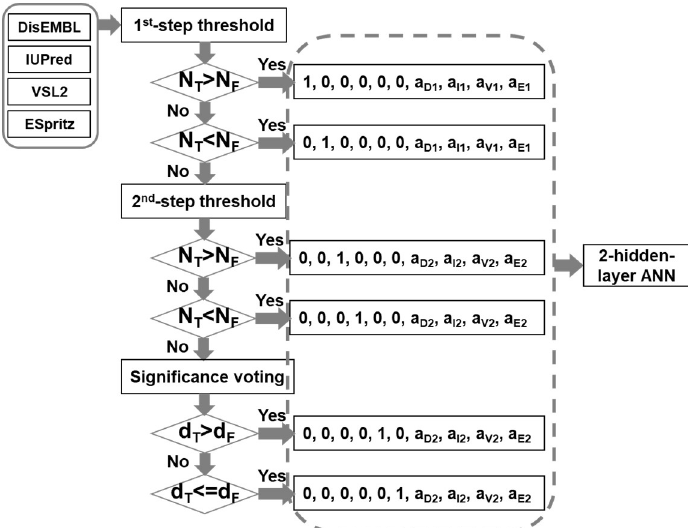
Figure 6. Infrastructure of the new meta-strategy. N T and N F are the numbers of predictors making true prediction and false prediction, respectively. “a1” and “a2” are the differences of prediction score from the 1st-step threshold and the 2nd-step threshold values, respectively. The letter subscripts represent DisEMBL (D), IUPred(I), VSL2(V), and ESpritz(E), accordingly. “d T ” and “d F ” are Euclidean distances of prediction scores from their corresponding threshold values for true predictions and false predictions, accordingly.